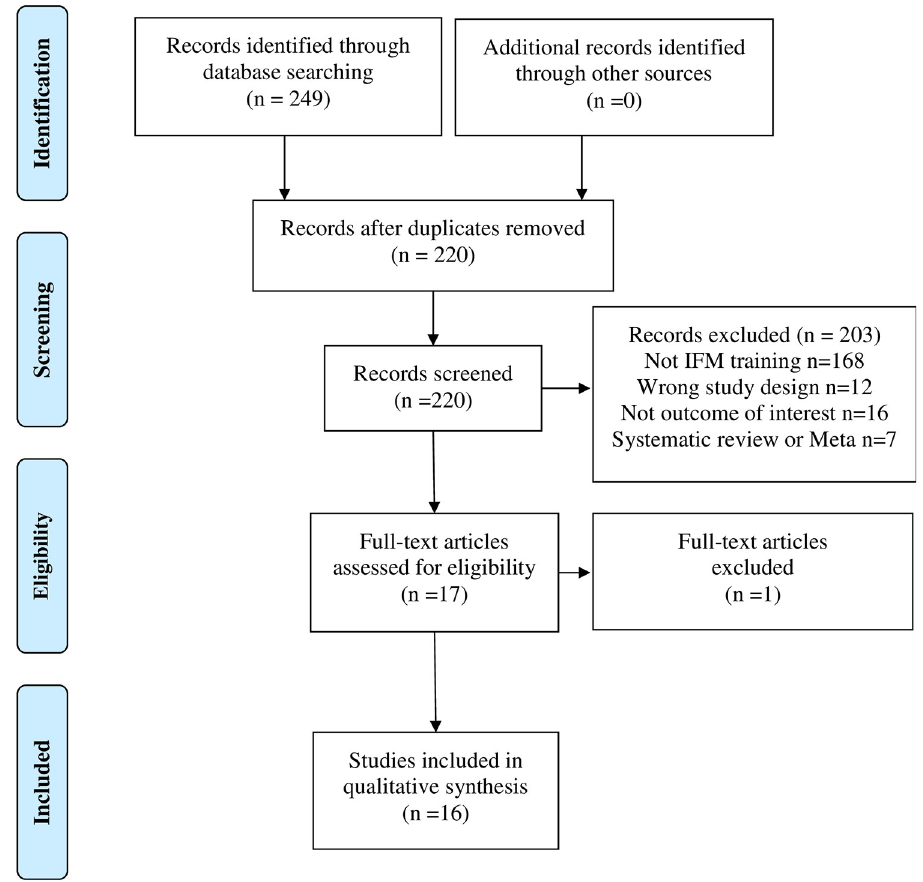
Fig 1. Flow diagram of literature